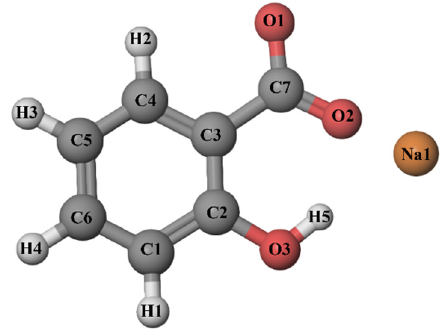
Figure 2. Structure of sodium salicylate molecule and atom-numbering scheme.